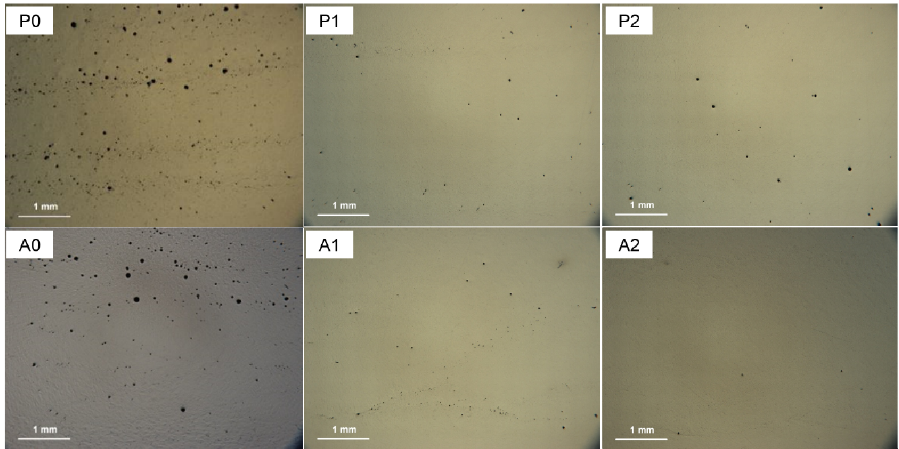
Figure 6. Optically observed porosity for the WAAM 2319 aluminum alloys: P0–P2 were produced by CMT ‐ P; A0–A2 were produced by CMT ‐ ADV.